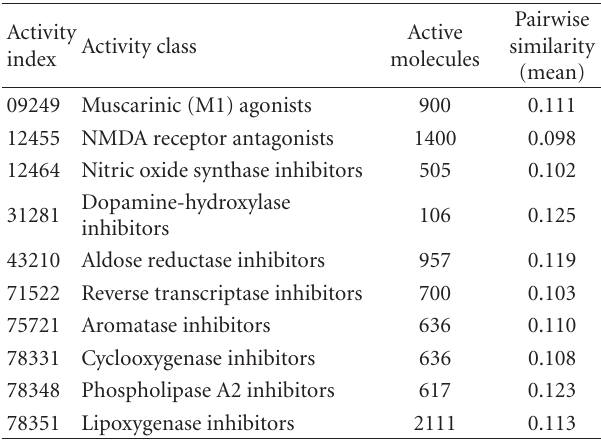
Table 3: MDDR activity classes for DS3